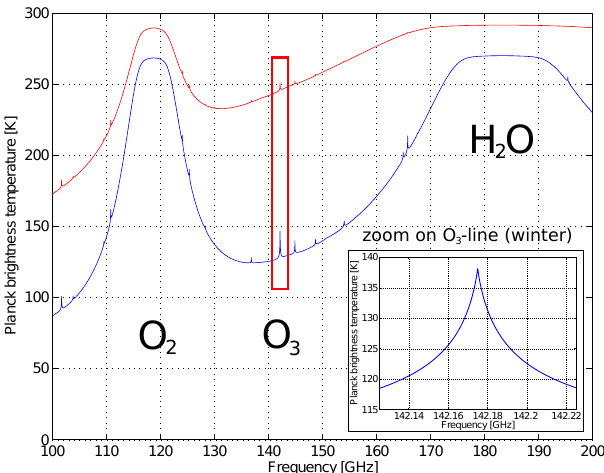
Fig. 3. The emission spectrum of the atmosphere in 20 ◦ elevation for a mid-latitude winter (blue) and summer (red) standard atmo- sphere calculated using ARTS (Buehler et al., 2005). The ozone line used for our experiment is marked by the red rectangle.